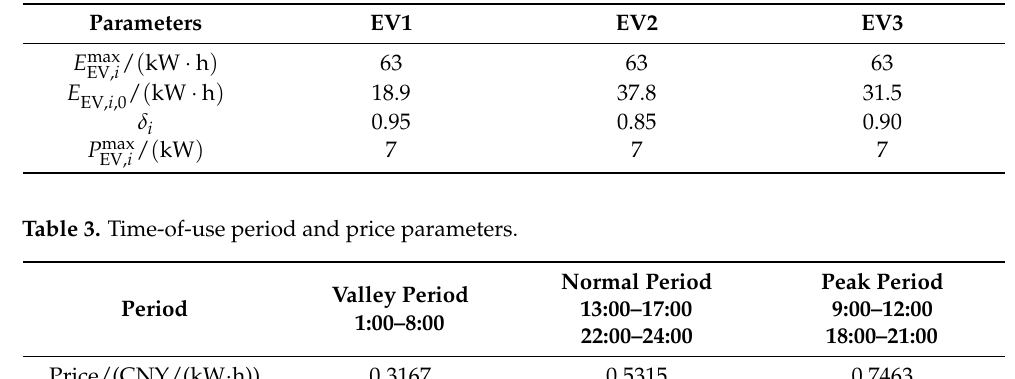
Table 2. Electric vehicle parameters.